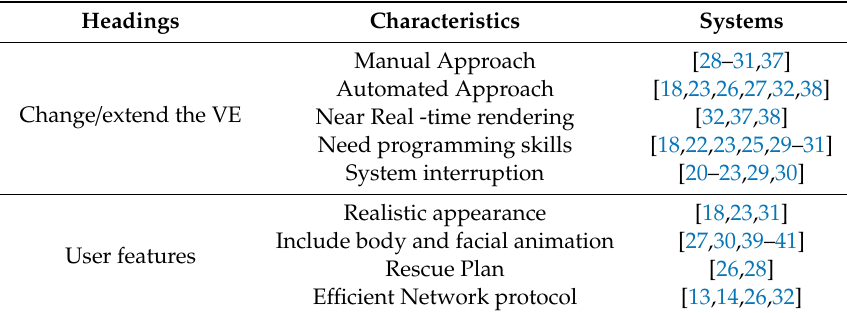
Table 1. 3D modeling Systems